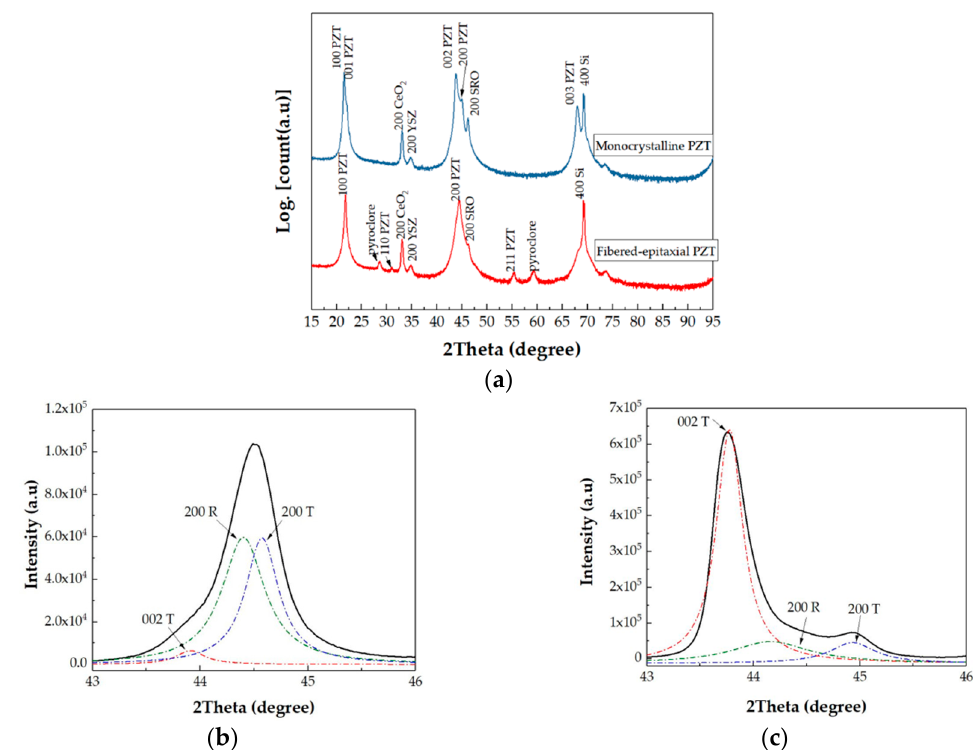
Figure 3. Typical SEM cross-section images of ( a ) monocrystalline and ( b ) fibered-epitaxial thin films.